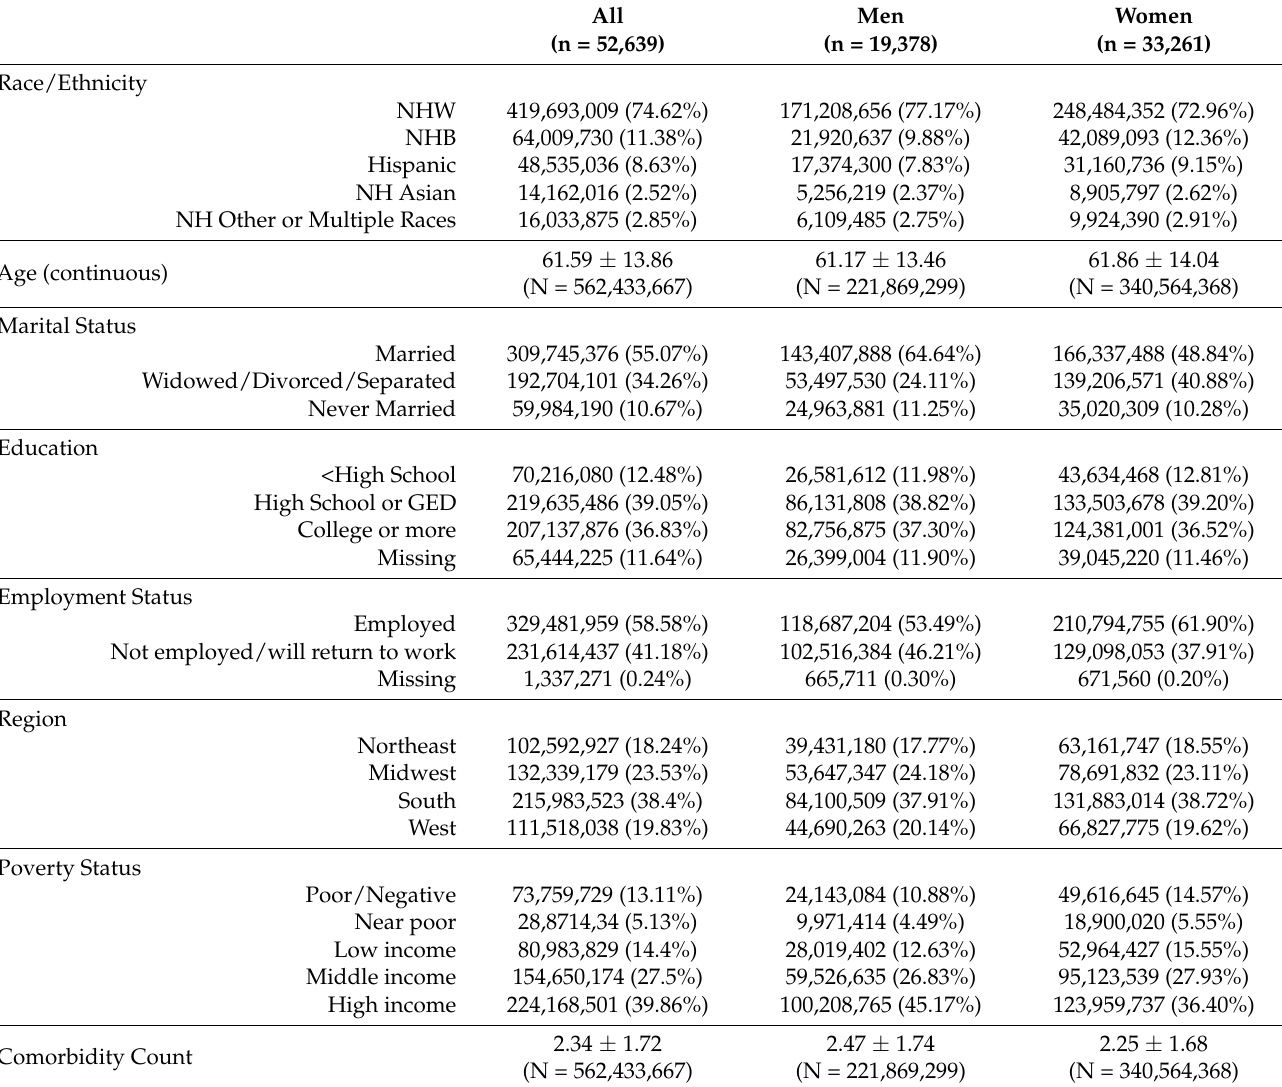
Table 1. Sample characteristics of men and women with a self-reported arthritis diagnosis: United States